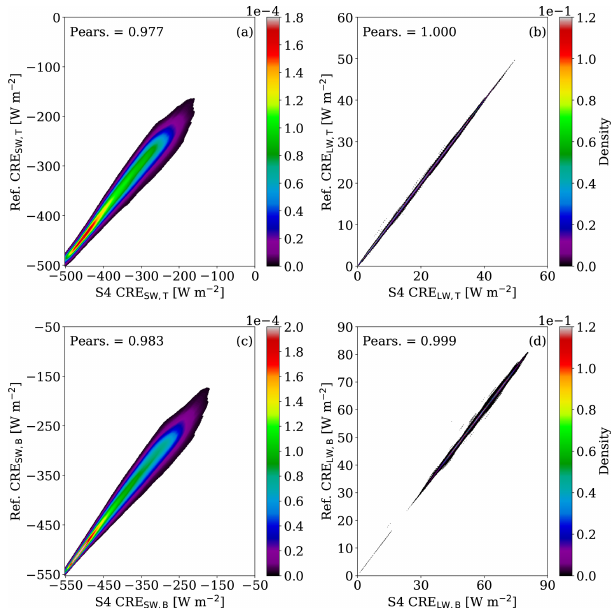
Figure B1. BKD between the reference simulation (ref.) and the scenario that employs the mean vertical N d profile (S4). For the CREs, BKDs are presented for the SW radiation at the TOA (a) and BOA (c) , and for the LW radiation at the TOA (b) and BOA (d) . The corresponding Pearson (Pears.) correlations are